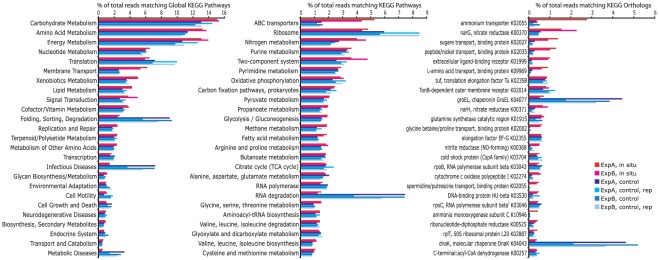
Twenty-five most abundant KEGG categories, ordered according to rank abundance in the Experiment A in situ dataset.KEGG categories are shown at increasing levels of resolution: Global Pathways (left), Pathways (center), and Orthologs (right). Abundances are expressed as percentages of the total number of reads with matches in KEGG (per dataset).